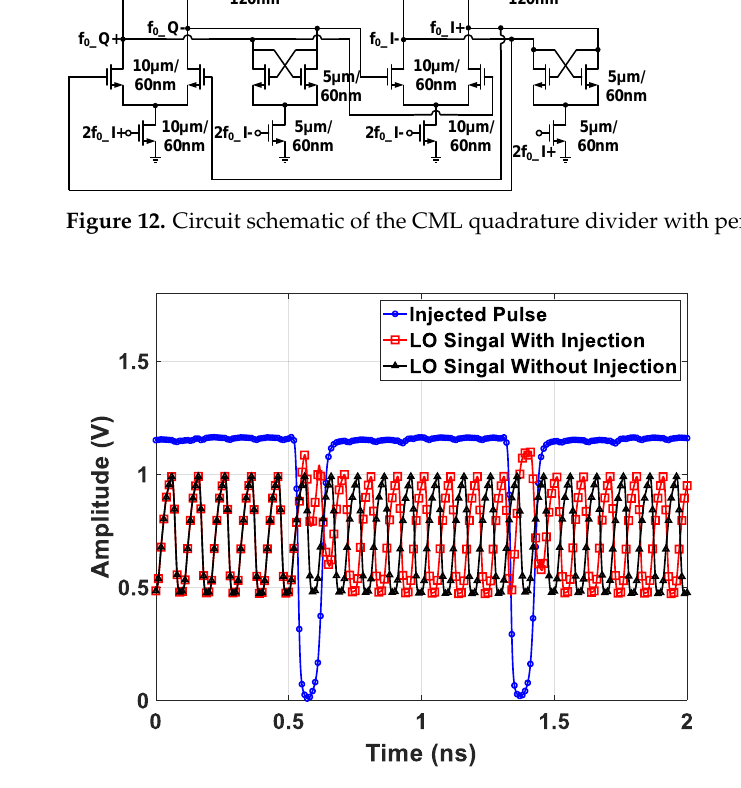
Figure 13. Simulated 10 GHz LO waveforms under deactivating and activating 1.25 GHz pulse